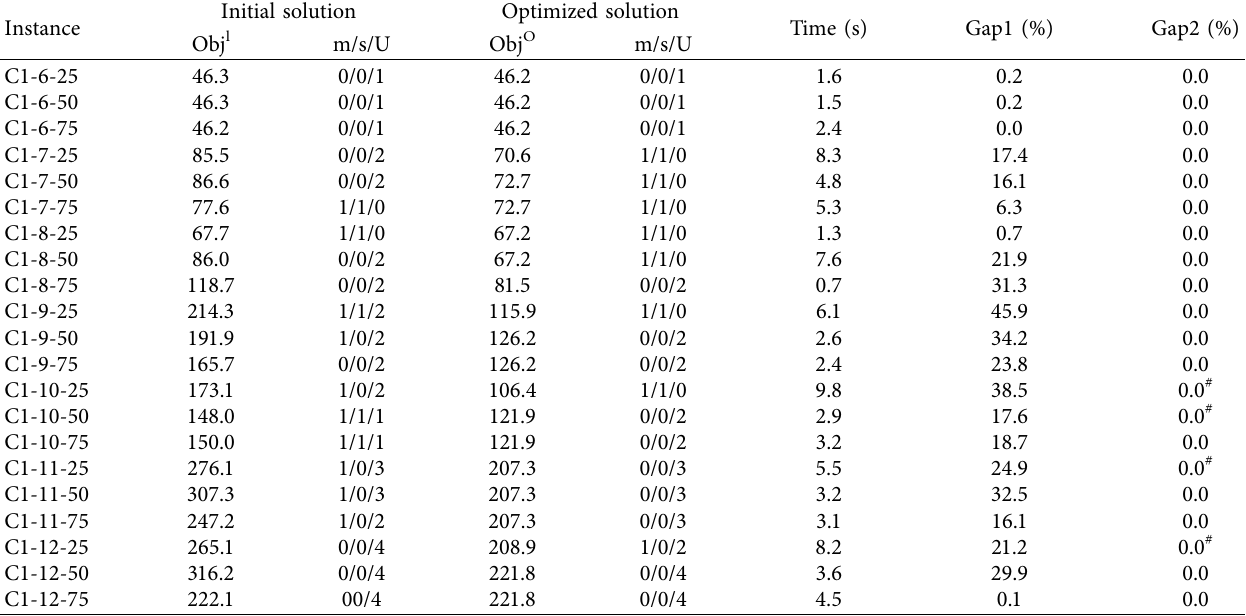
Table 4: Heuristic solutions for 21 small-scale